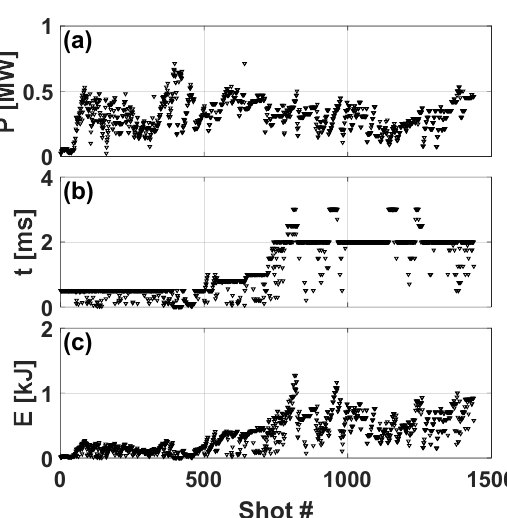
Fig 1. Conditioning of a klystron during ~1500 pulses. Pulse power is plotted in (a), pulse width is plotted in (b), and pulse energy is plotted in (c).